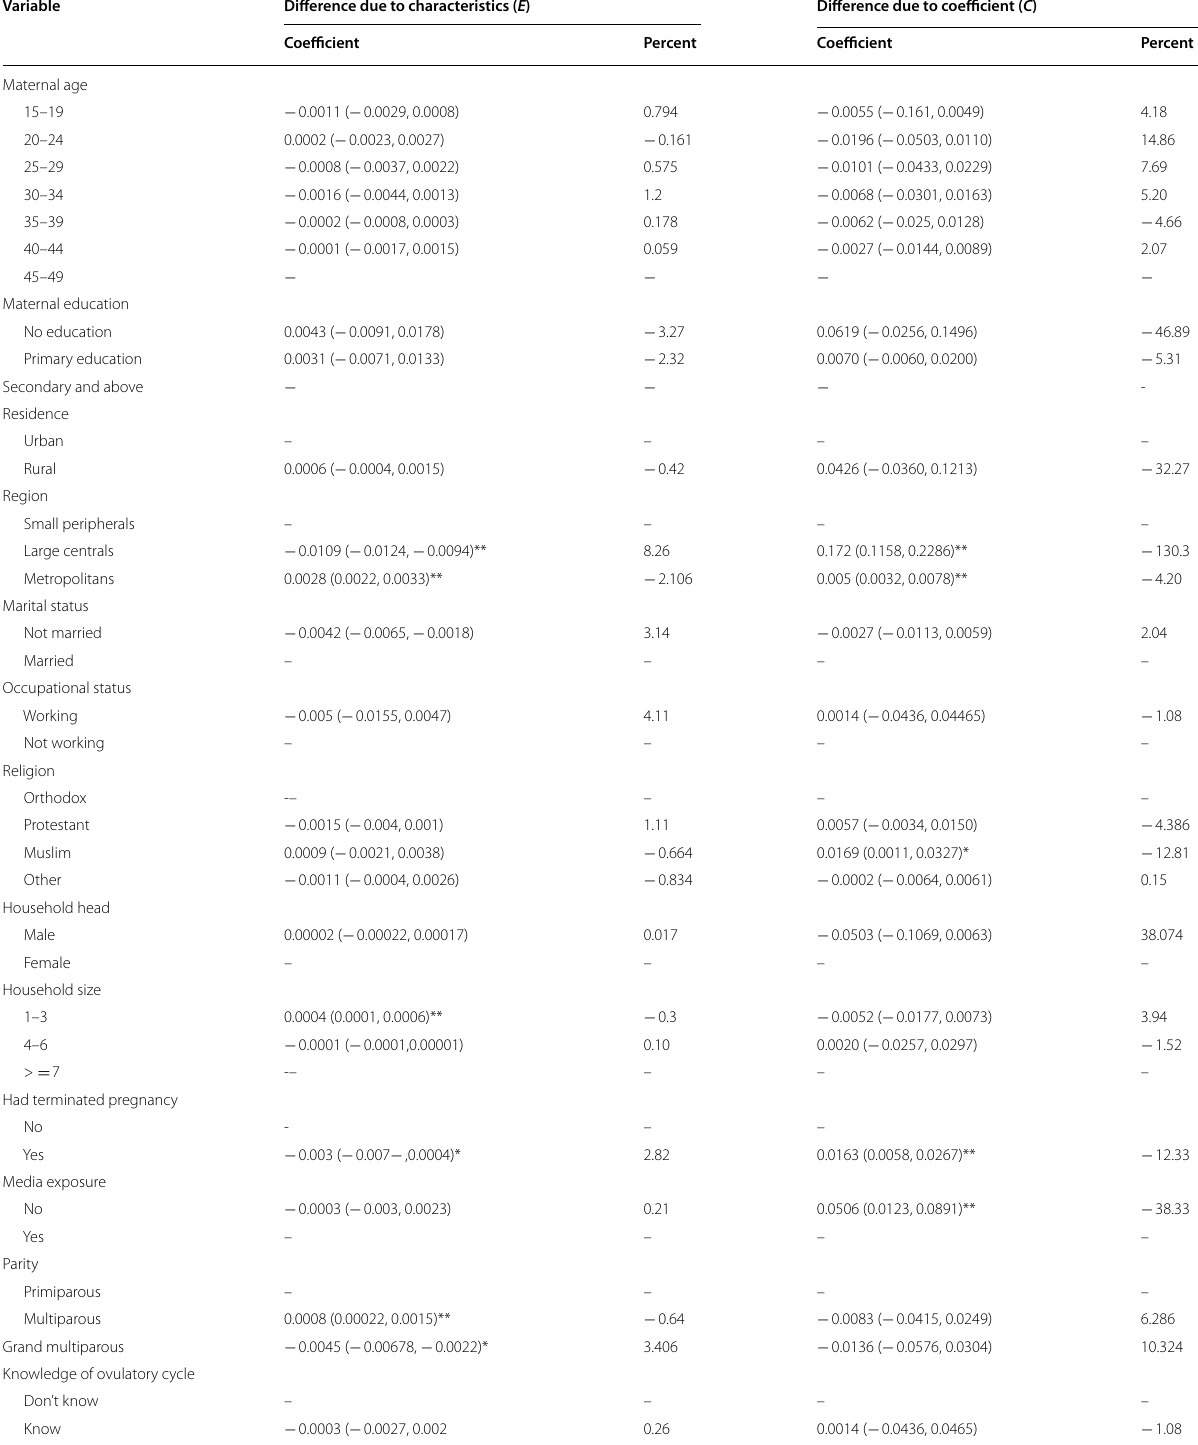
Table 4 The detailed decomposition analysis of the change in unintended pregnancy among reproductive-age women in Ethiopia from 2000 to 2016